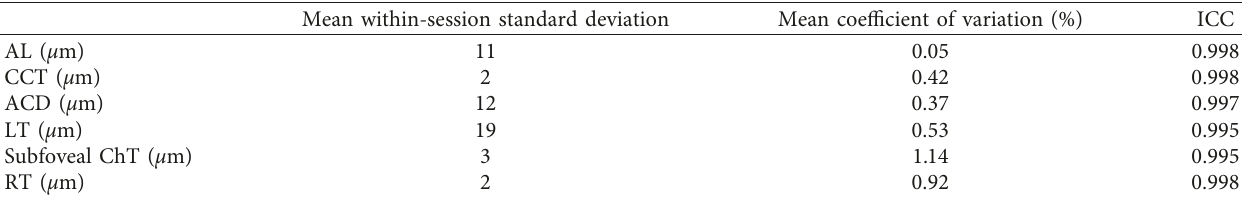
Table 1: Outline of within-session repeatability and reliability for each of the variables measured at each measurement session. Mean within-session standard deviation Mean coefficient of variation (%)